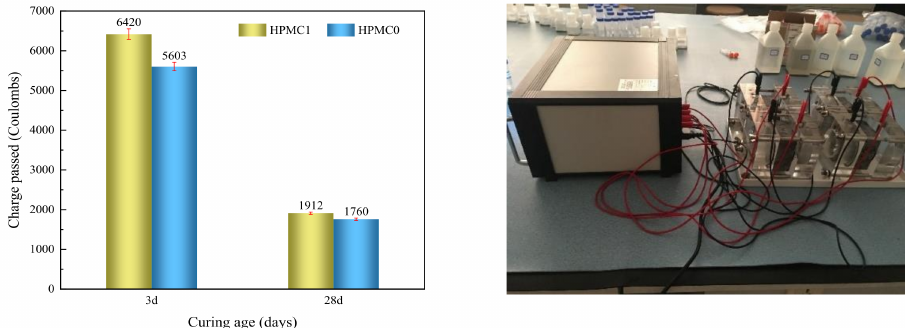
Figure 6. The charge passed of concrete with and without HPMC at different curing